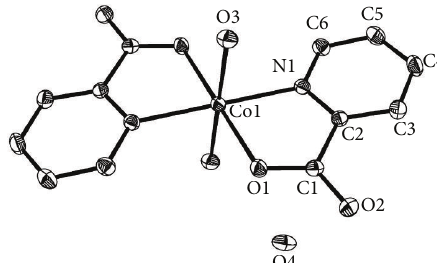
Figure 1: Molecular structure of the title complex.